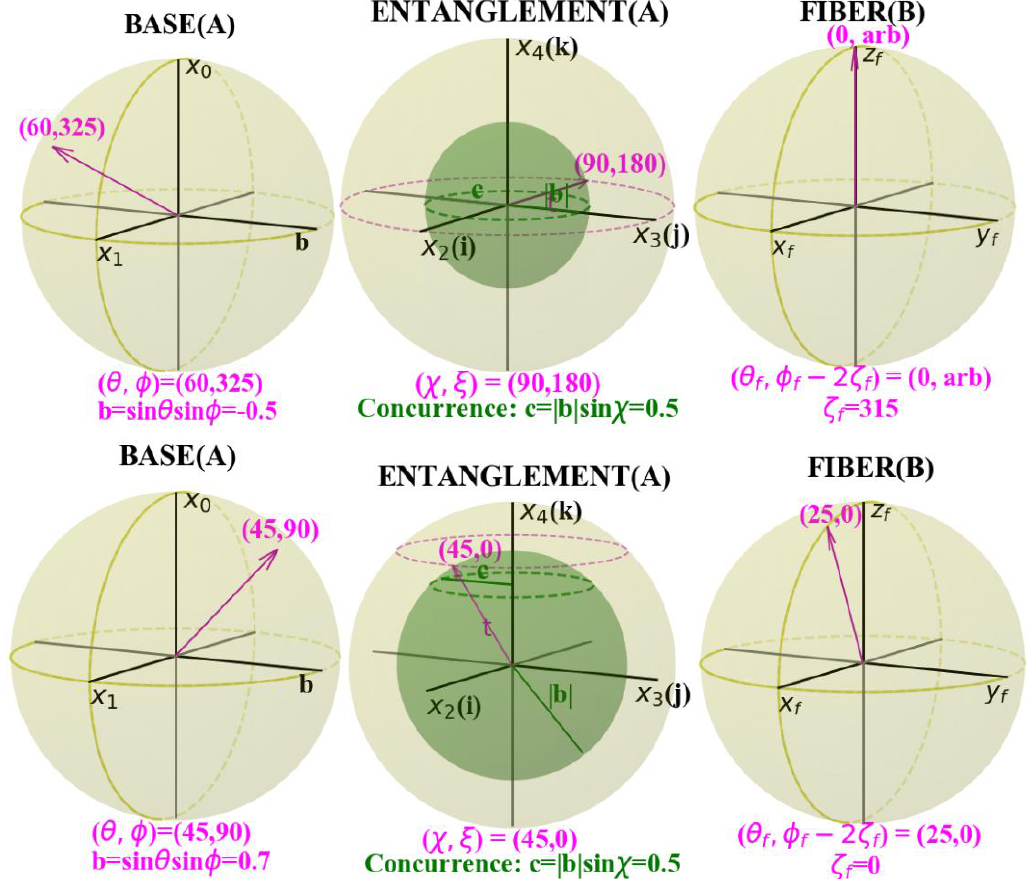
Figure 8. Base qubit local operation examples: R x (60 ◦ ) ⊗ I → C-R y (70 ◦ ) → R z (90 ◦ ) ⊗ I ( top row ) and R x (60 ◦ ) ⊗ I → C-R y (70 ◦ ) → R x ( − 90 ◦ ) ⊗ I ( bottom row ). After the top row of Figure 6, R z (90 ◦ ) or R x ( − 90 ◦ ) is applied to qubit-A. Compare the base and entanglement spheres with the corresponding ones in the top row of Figure 6. A local z - or x -rotation of the base sphere affects both the base and entanglement coordinates as the b -value is changed by the rotation.